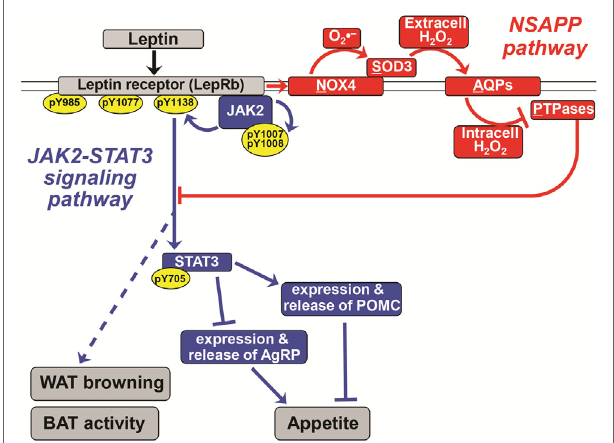
FigURe 1 | A novel pathway essential for canonical leptin signaling in hypothalamic neurons. Leptin activates signaling pathways to control the expression of appetite-regulating neuropeptides [proopiomelanocortin (POMC) and agouti-related peptide (AgRP)] in hypothalamic neurons. The canonical Janus kinase 2 (JAK2)–signal transducer and activator of transcription 3 (STAT3) signaling pathway is shown in blue. In red is the newly discovered NSAPP pathway that we showed to be essential for producing an intracellular burst of H 2 O 2 that inhibits key protein tyrosine phosphatases (PTPases), thereby allowing canonical leptin signaling to propagate. Normal leptin signaling is required to suppress appetite and to stimulate white adipose tissue (WAT) browning and brown adipose tissue (BAT) thermogenic activity. Pointed arrowheads indicate stimulation of the immediately downstream molecule or process; flat arrowheads indicate inhibition. Specific phosphorylation sites are indicated within yellow ovals. The double line indicates the plasma membrane; all molecules above it are extracellular, and all named molecules below it in the schematic are intracellular. The leptin receptor (LepRb), NADPH oxidase-4 (NOX4), and aquaporins are transmembrane molecules. Solid lines represent experimentally demonstrated pathways; dotted lines are less well-characterized or putative. Adapted from Ref.